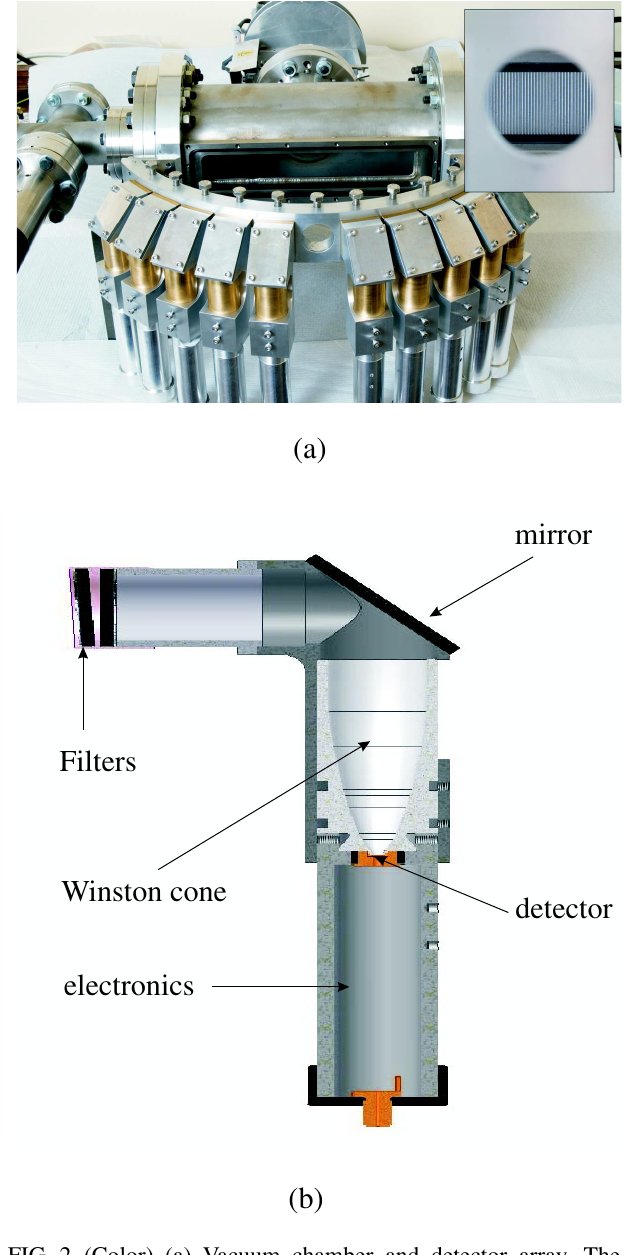
FIG. 2. (Color) (a) Vacuum chamber and detector array. The inset shows a view of one grating as seen through the 90 (cid:8) port, from which the detector, Winston cone, and bending mirror assembly have been removed. (b) Schematic of 90 (cid:8) elbow and Winston